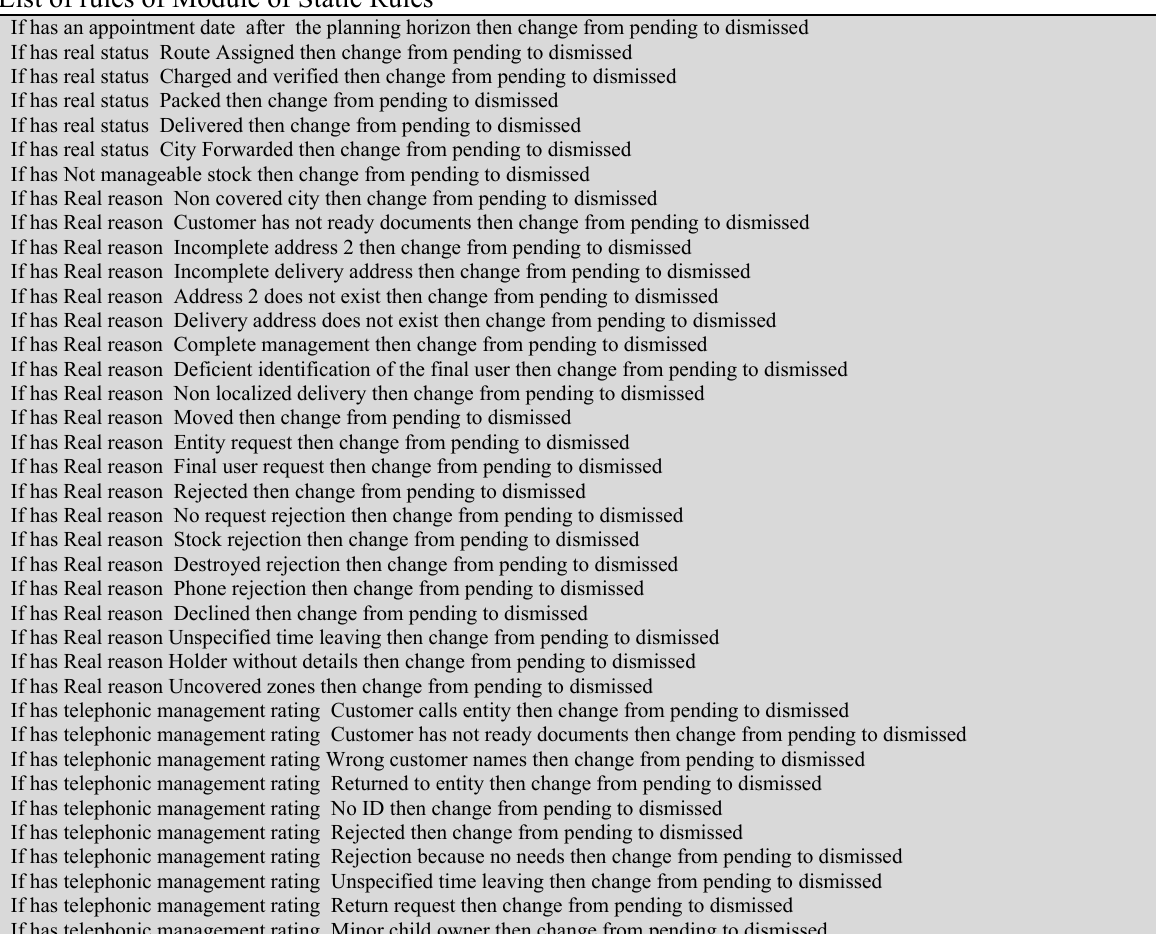
Table A1 lists the set of rules that are used in Module of Static Rules for the expert system in scheduling phase. Table A1 List of rules of Module of Static